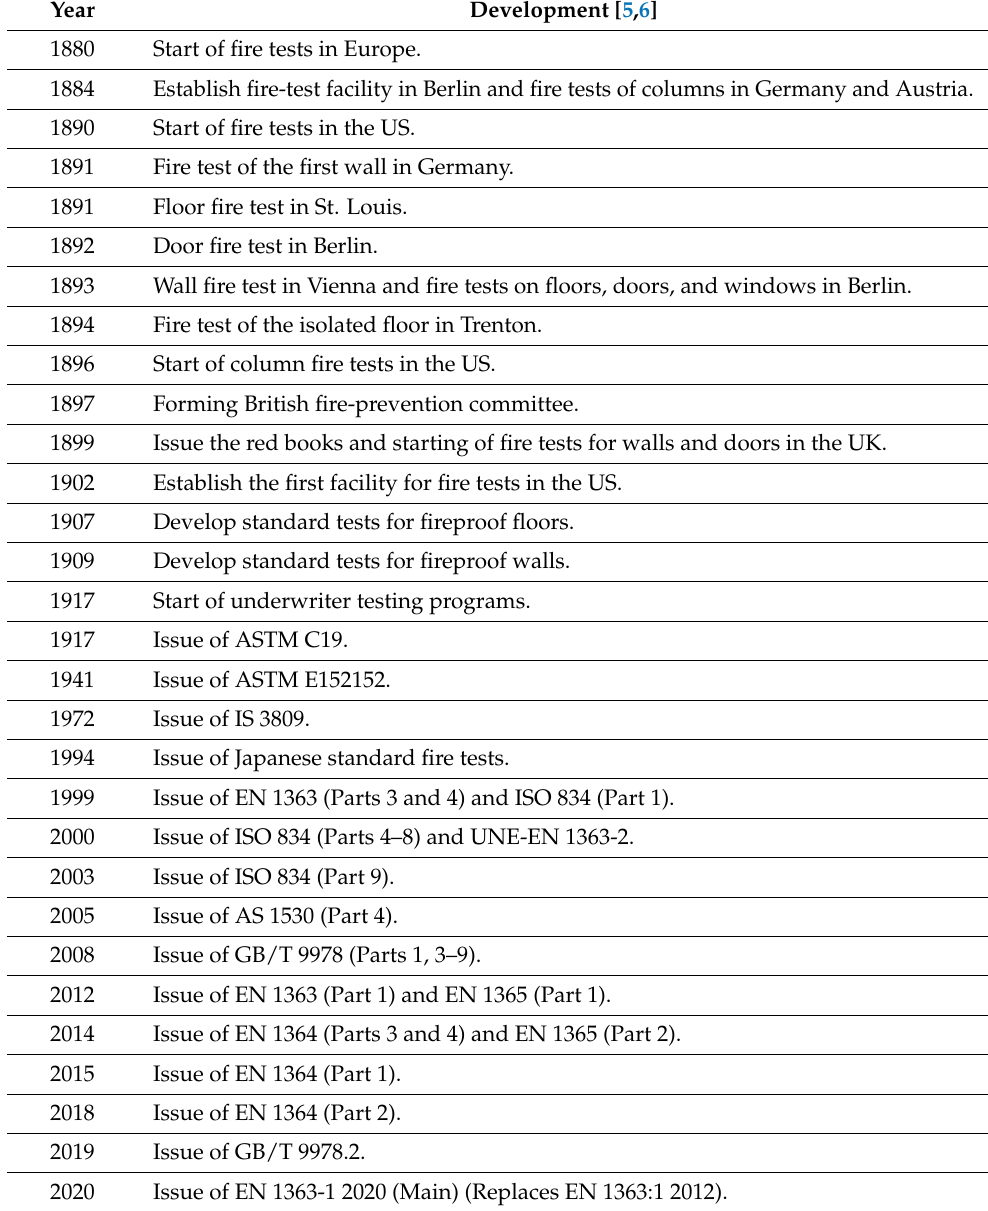
Table 1. Historical development of fire-resistance